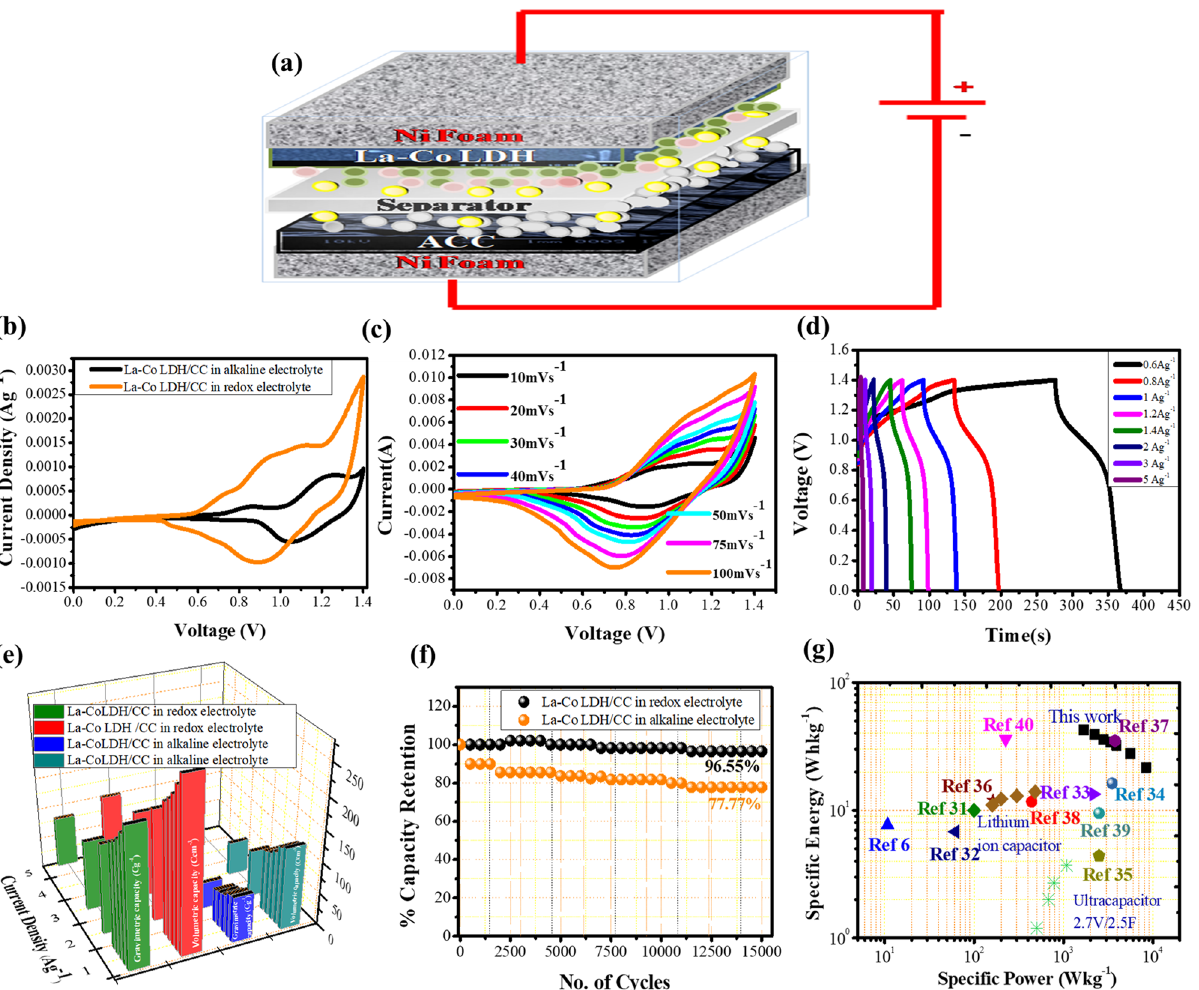
Figure 4. ( a ) Schematic representation of two electrode cell fabricating by using La–Co LDH/CC, ( b ) comparative cyclic voltammetry curve of La–Co LDH/CC in alkaline and redox electrolyte, ( c ) CV curve of La–Co LDH/CC in redox electrolyte, ( d ) Galvanostatic charge discharge process at various current density, ( e ) comparative Gravimetric and Volumetric capacity of La–Co LDH/CC in redox electrolyte and alkaline electrolyte, ( f ) capacity retention plot of La–Co LDH/CC showing high cyclic stability at redox electrolyte compare to alkaline electrolyte, ( g ) comparative Ragone plot of specific energy and specific power of La–Co LDH/CC with reported literatures 31–40